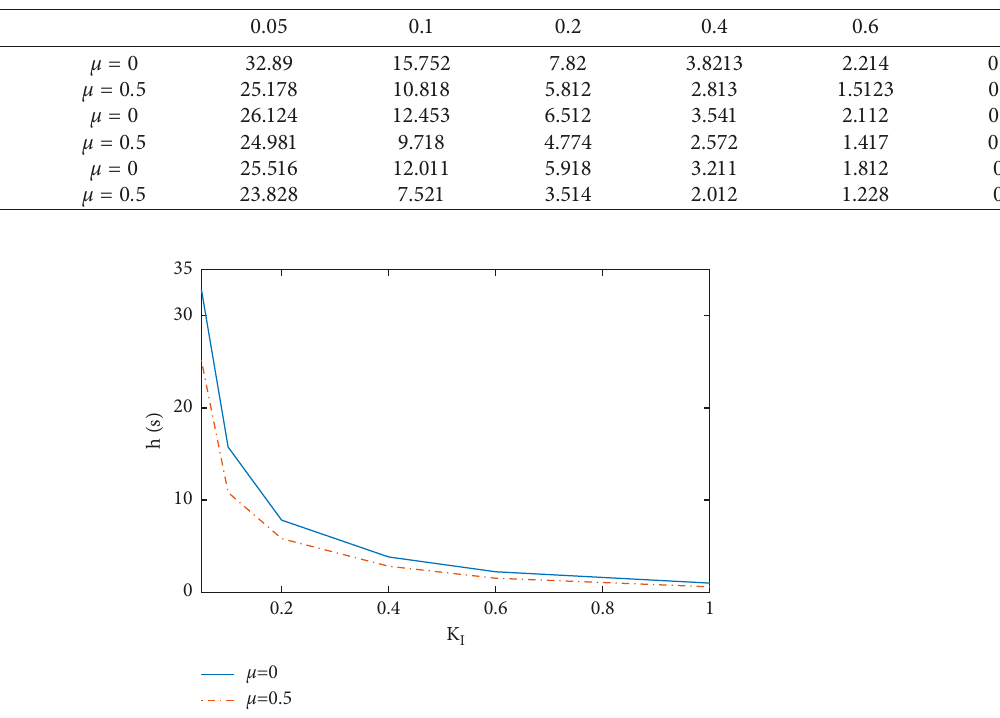
I for single-area with